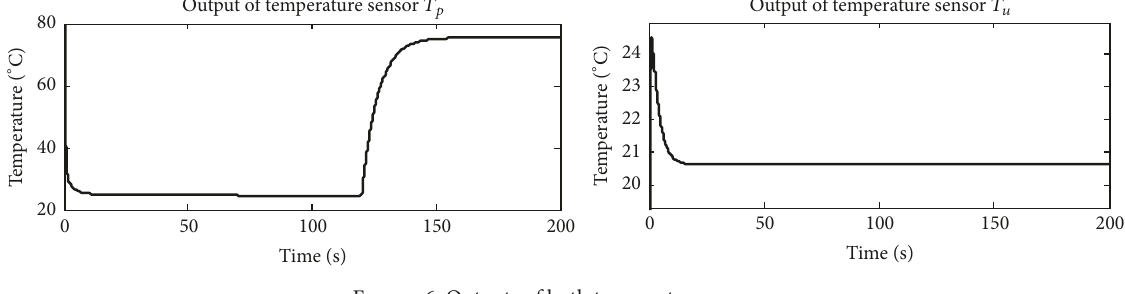
Figure 6: Outputs of both temperature sensors.